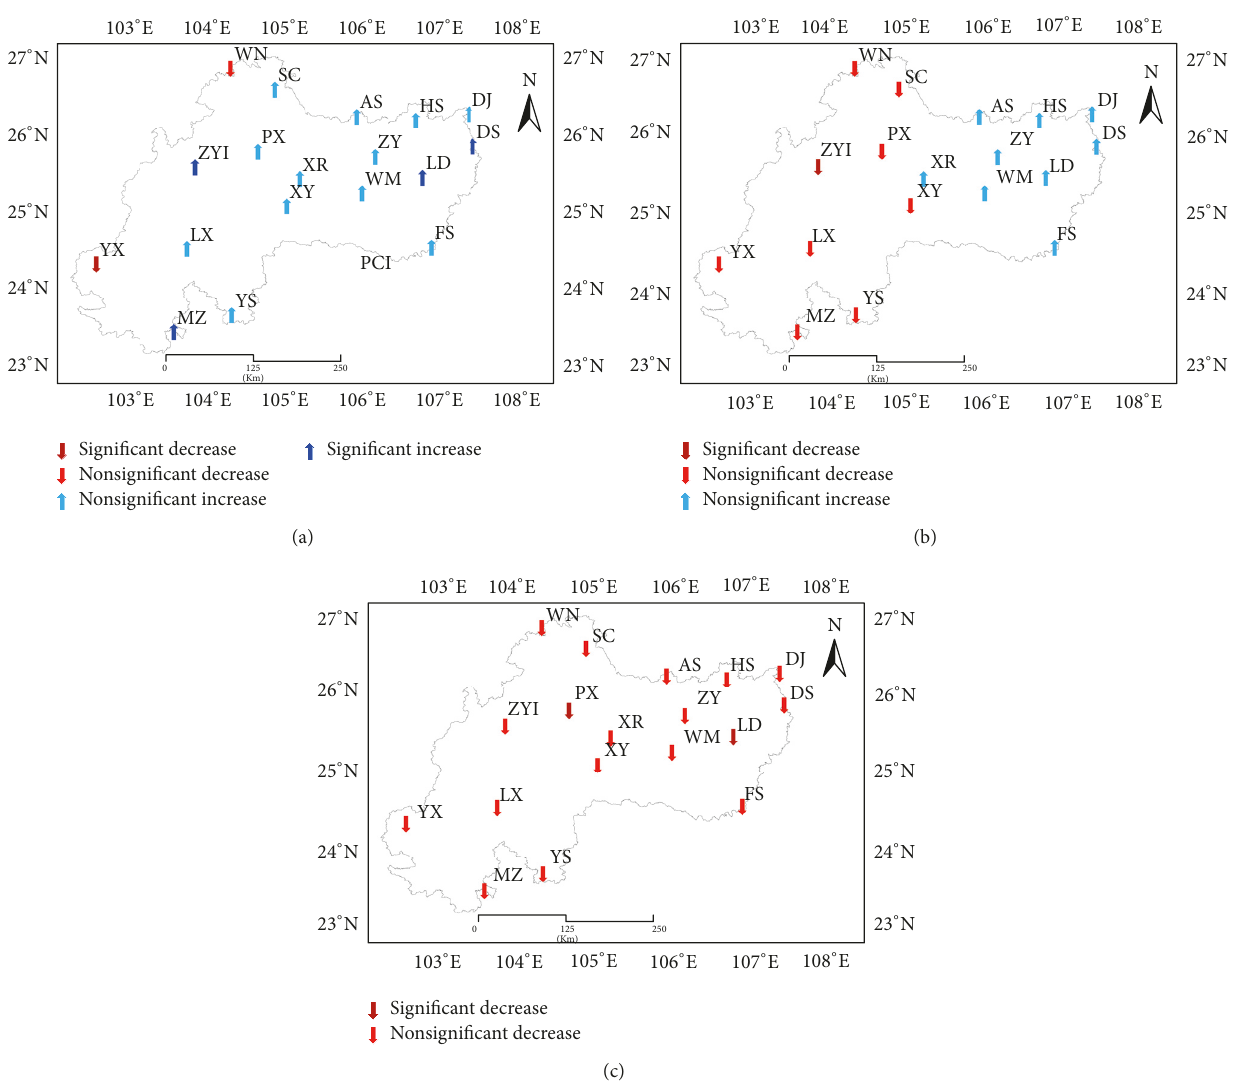
Figure 4: Spatial distributions of the observed PCI (a), PCD (b), and PCP (c) trends in the UHRB from 1959 to 2015.